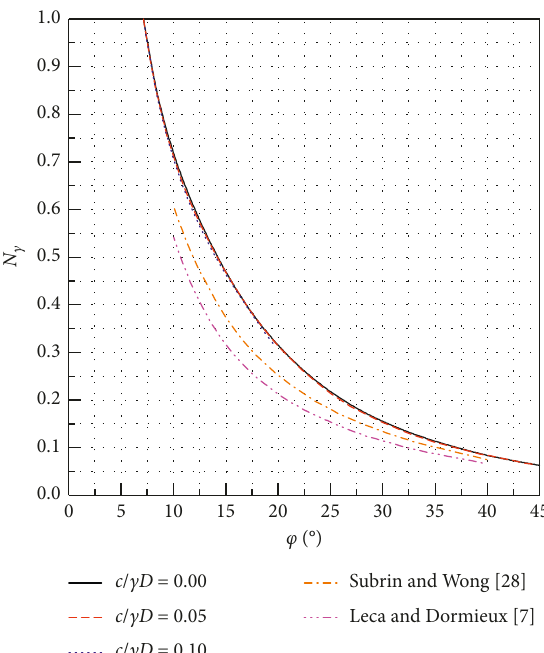
Figure 10: Dimensionless parameter N c for tunnel face stability.